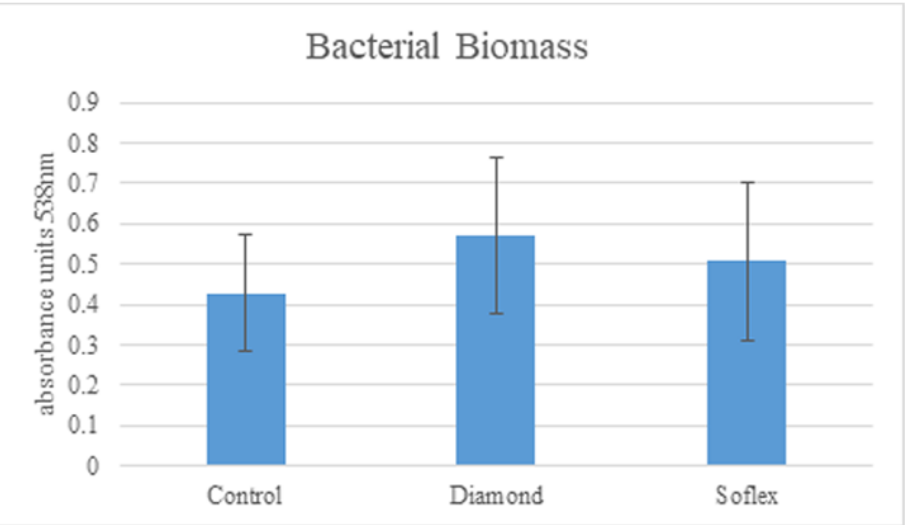
Figure 6. Biofilm biomass quantification using crystal violet staining after 48 h growth of S. mutans on discs polished by Shine 1–2 diamond burs, Sof-Lex discs, and non-polished discs that served as the control. The statistical significance in comparison with the control is p < 0.05.